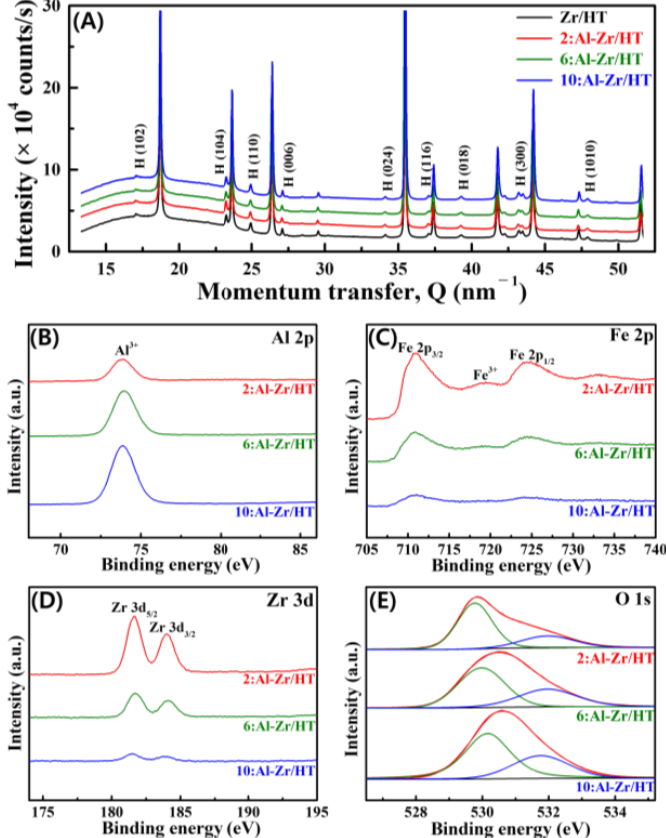
Figure 2. ( A ) A series of SR-XRD patterns from the Zr/HT, 2:Al-Zr/HT, 6:Al-Zr/HT, and 10:Al-Zr/HT photoanodes; and the XPS spectra obtained of ( B ) Al 2p, ( C ) Fe 2p, ( D ) Zr 3d, and ( E ) O 1s for the 2:Al-Zr/HT, 6:Al-Zr/HT, and 10:Al-Zr/HT photoanodes.